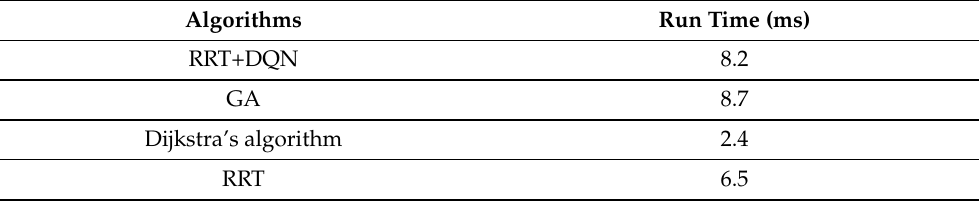
Table 4. Path planning algorithm mean run time with 10 obstacles in a 300 m³